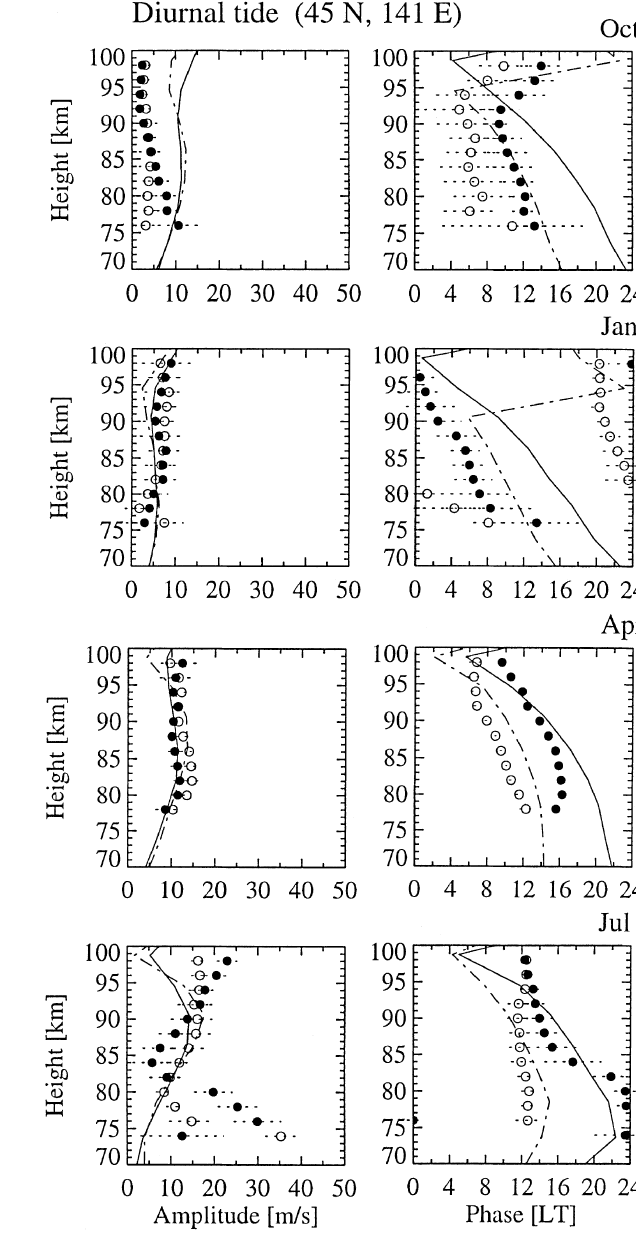
Fig. 5. Monthly means of amplitude and phase profiles of the diurnal tide at Yamagawa (31 (cid:176) N). Solid circles are due to the observed eastward component, open circles indicate the northward component. The dotted horizontal lines are the error bars due to the variability of the tides within the month. The tidal profiles of the global scale wave model (GSWM) by Hagan et al. (1995) are drawn as a solid line for the eastward component and as a dash-dotted line for the northward component (height resolution is 4 km)